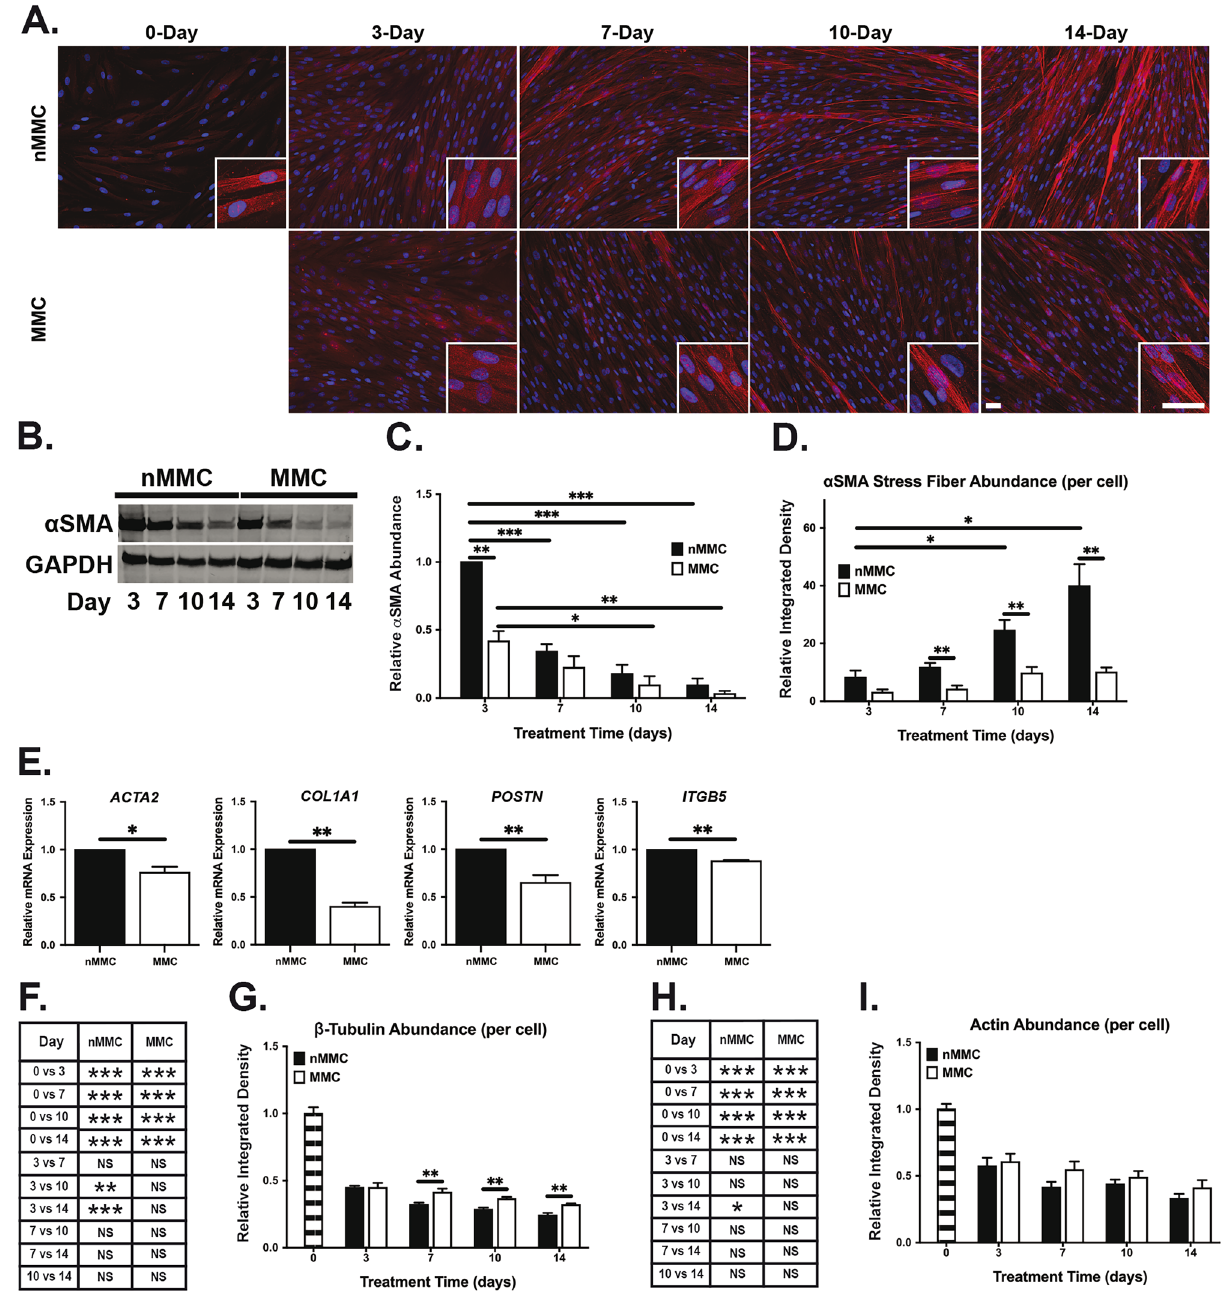
Figure 7. Characterization of myofibroblast-associated markers and cytoskeletal proteins in MMC and nMMC cultures. ( A ) Representative standardized images of αSMA immunostaining from each time point and treatment from two repeated experiments. Inserts show higher magnification of select areas. Images in inserts are individually optimized for brightness/contrast. Magnification bars = 40 μm. ( B ) Representative Western blot of αSMA in MMC and nMMC cultures at day 3–14. GAPDH was used as loading control. Cropped images of Western blots are shown. ( C ) Quantitation and statistical comparison of change in αSMA abundance at each time point and over time relative to GAPDH determined by Western blotting. Results show mean + /− SEM from four repeated experiments. ( D ) Quantification (mean + /− SEM) of αSMA stress fibers by image analysis over time and in pairwise comparison at each time point. ( E ) Quantification (mean + /− SEM) of expression of ACTA2 , COL1A1 , POSTN and ITGA5 by RT-qPCR in MMC relative to nMMC cultures at day 14 (n = 4–7 repeated experiments). ( F ) Statistical comparison of change in relative (normalized for cell numbers determined by nuclear DAPI counts) β-tubulin abundance over time. ( G ) Pairwise comparison of relative β-tubulin abundance at each time point. ( H ) Statistical comparison of change in relative (normalized for cell numbers determined by nuclear DAPI counts) actin abundance over time. ( I ) Pairwise comparison of relative actin abundance at each time point. Results show mean + /− SEM ( D , G , I ) and statistical comparison over time ( F , H ) from image analysis from 6–12 images obtained from each time point and treatment from two repeated experiments. Statistical comparison between time points was performed by one-way ANOVA ( C , D , F , H ) and between treatments at each time point by independent samples t-test ( C , D , E , G , I ), *p < 0.05; **p < 0.01; ***p <